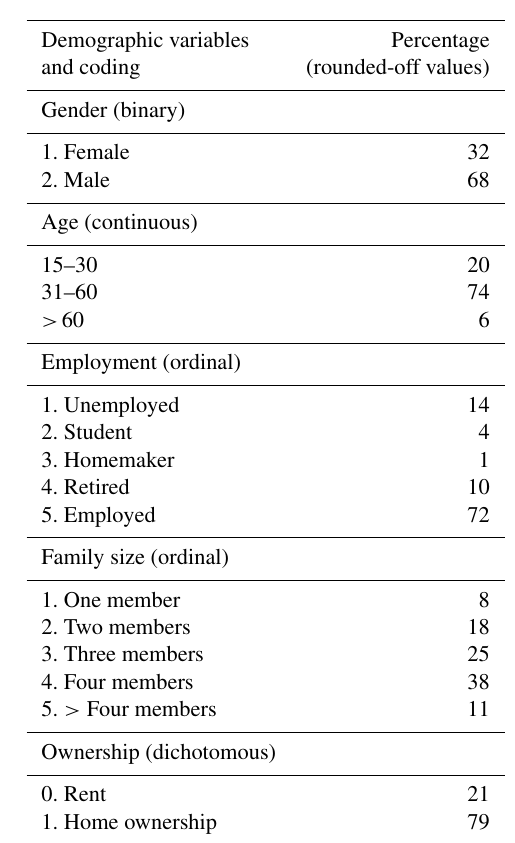
Table 2. Demographic characteristics of the survey sample and cod- ing of the respective FPB model